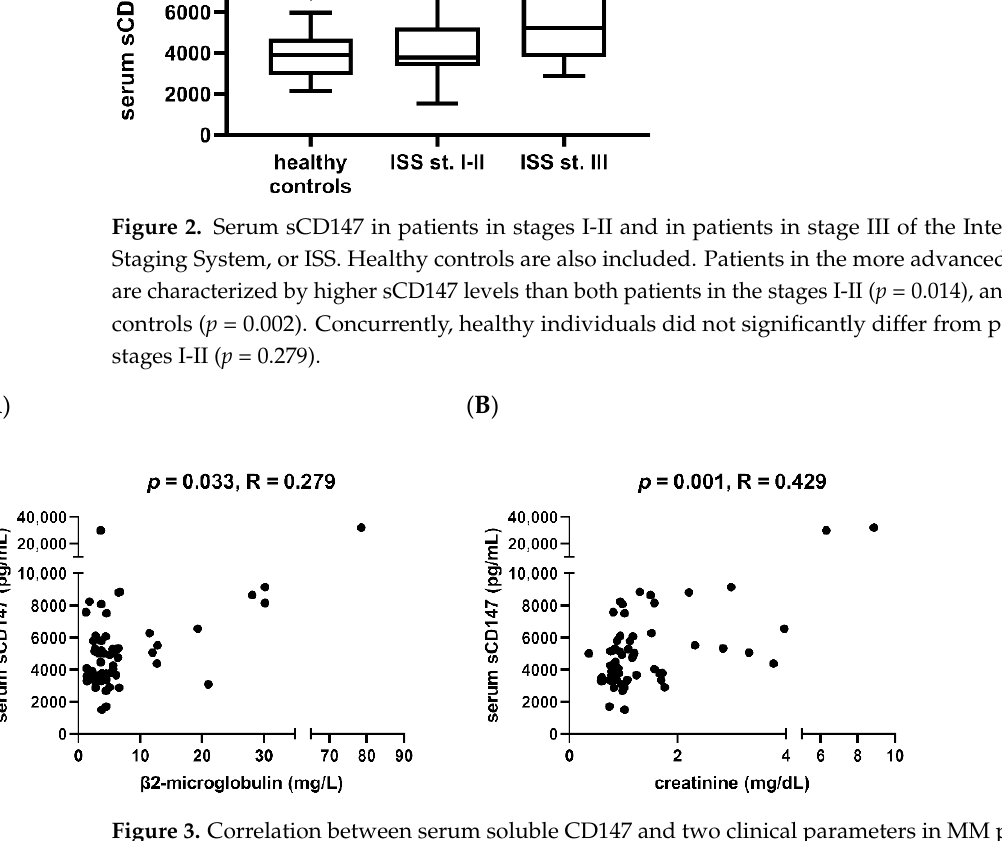
Figure 2. Serum sCD147 in patients in stages I-II and in patients in stage III of the International Staging System, or ISS. Healthy controls are also included. Patients in the more advanced stage III are characterized by higher sCD147 levels than both patients in the stages I-II ( p = 0.014), and healthy controls ( p = 0.002). Concurrently, healthy individuals did not significantly differ from patients in stages I-II ( p = 0.279).